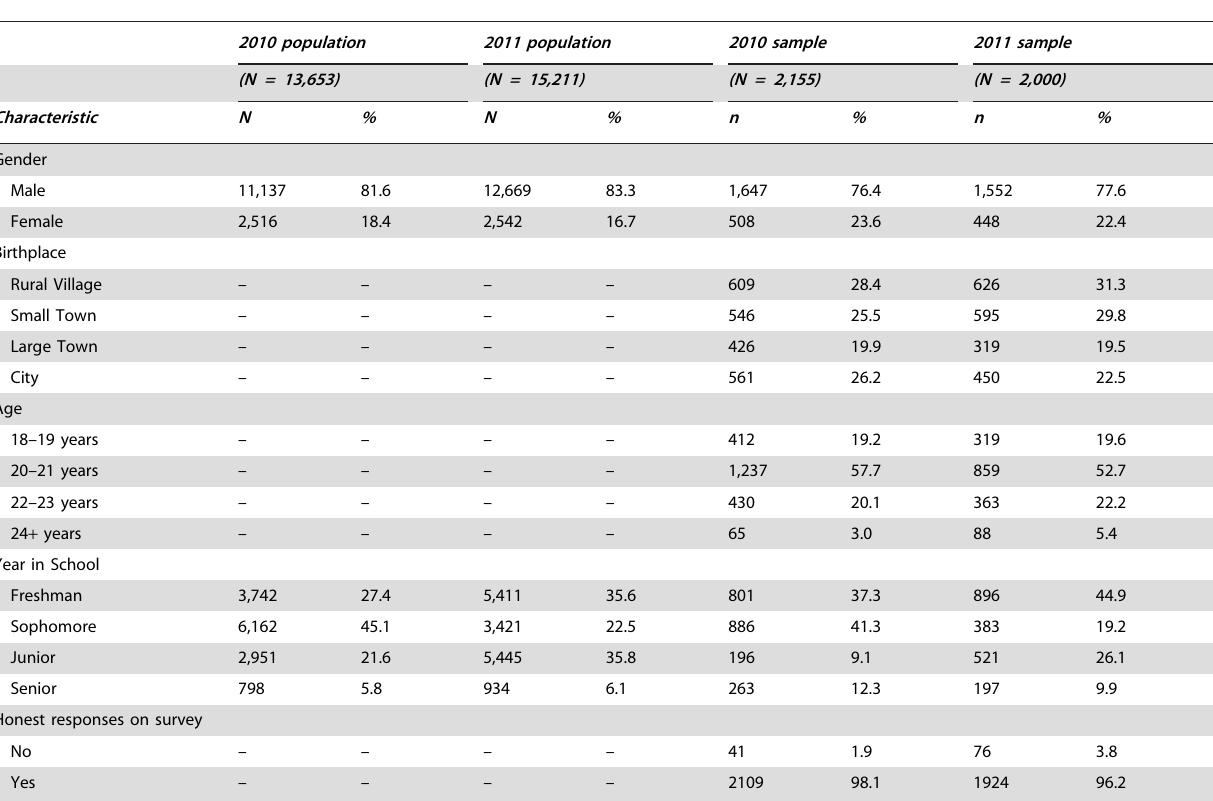
Table 1. Demographic characteristics of Hawassa University and student samples, 2010 and